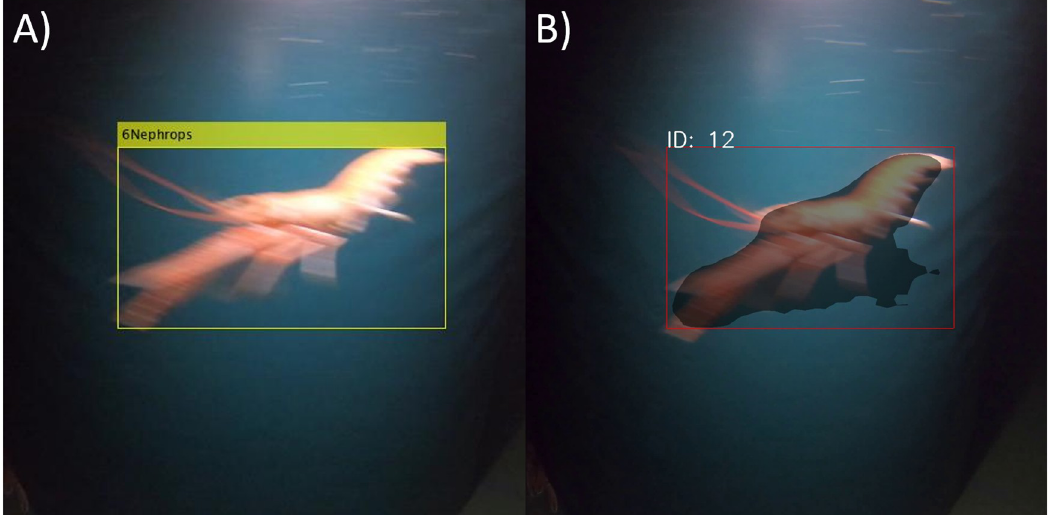
Fig 4. Example of detected and tracked N . norvegicus . (A) The output of the proposed computer vision algorithm; (B) the output of mask R-CNN pre-trained on COCO.